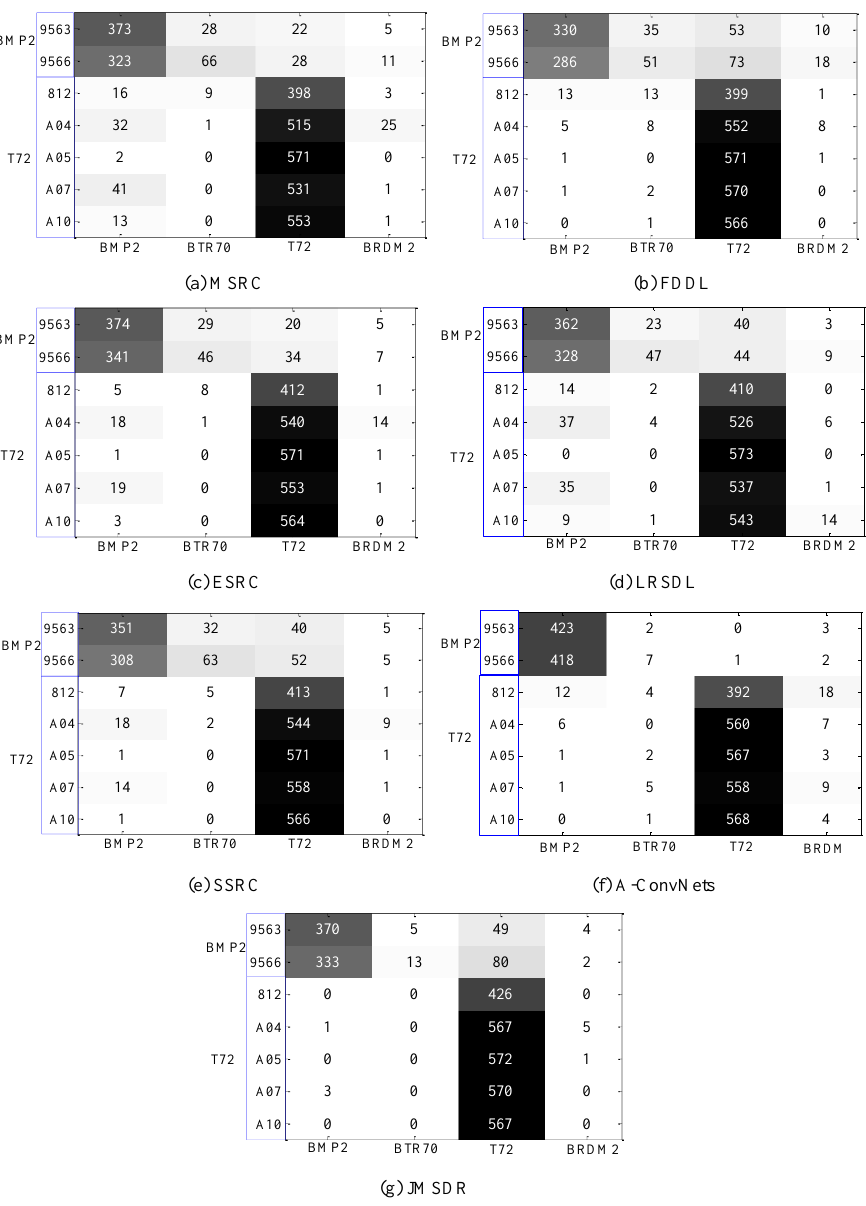
Figure 6. The confusion matrices of MSRC, FDDL, ESRC, LRSDL, SSRC, A-ConvNets and JMSDR under configuration variance